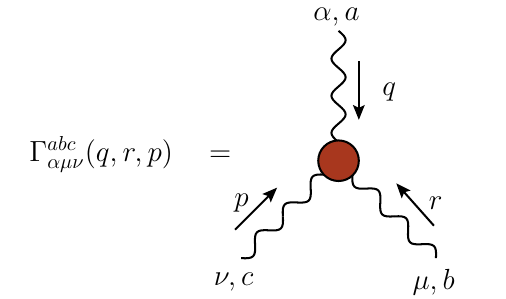
Fig. 1 Thethree-gluonvertexandthecorrespondingmomentum/index